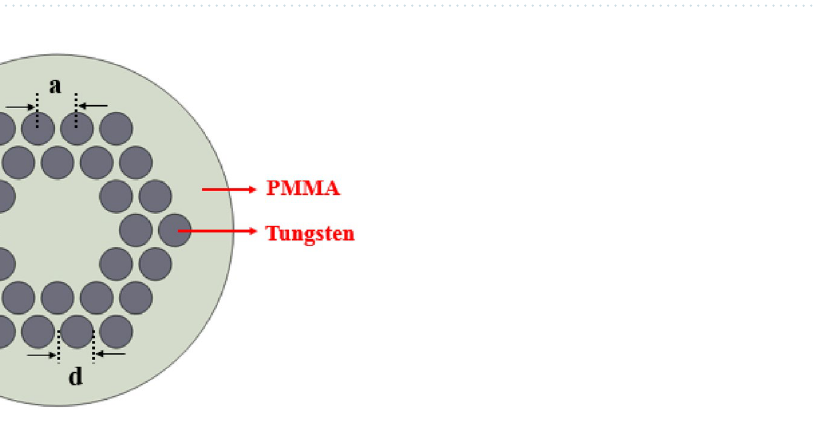
Figure 3. Displacement field of phononic crystal fiber with small core corresponding to incident waves with ( a ) x-component and frequency of 1158.1 kHz, ( b ) y-component and frequency of 738.9 kHz, and ( c ) z-component and frequency of 738.9 kHz in two input and output cut-planes.